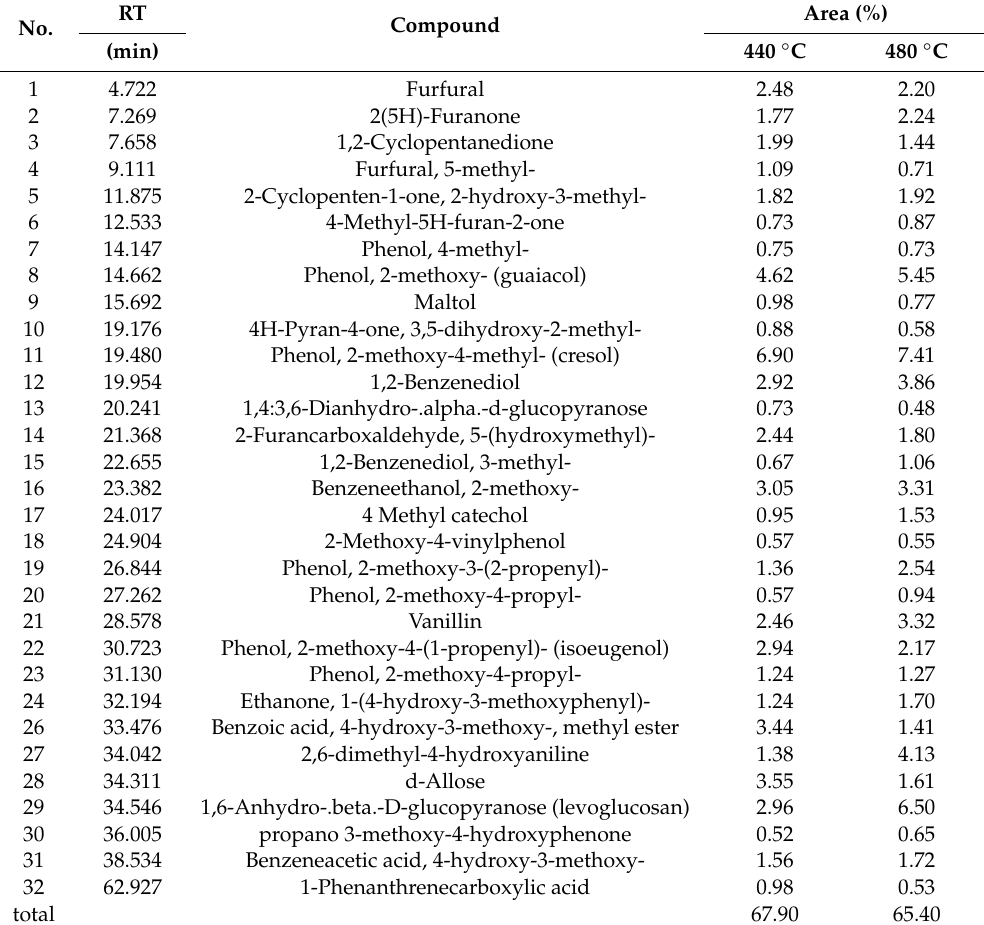
Comparison of major organic compounds in bio-oil products obtained at two di ff erent